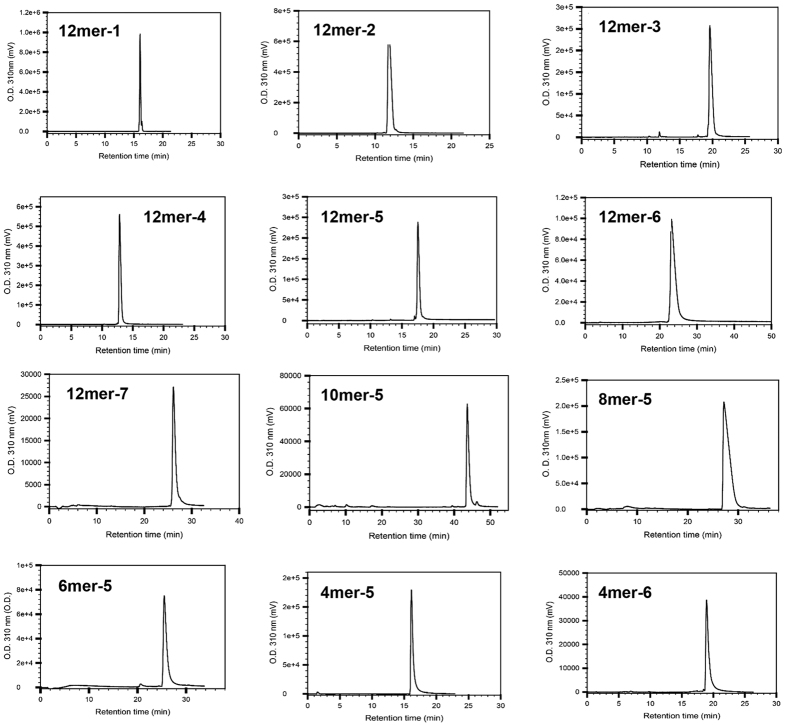
HPLC chromatograms of synthesized oligosaccharides.Both DEAE-HPLC and PAMN-HPLC methods were used to analyze the purity of each individual oligosaccharide. Overall, the purity for each compound was determined to be >90%.